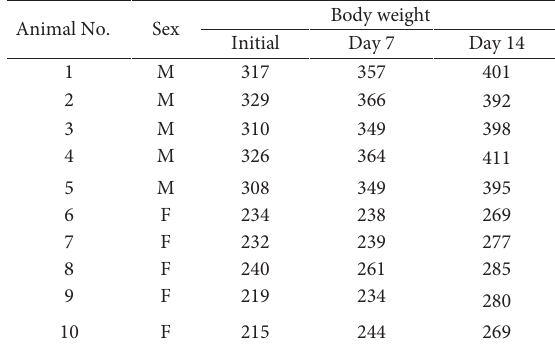
Table4.Individual body weights of fresh air control group Table 4. Individual body weights of fresh air control group Animal No.